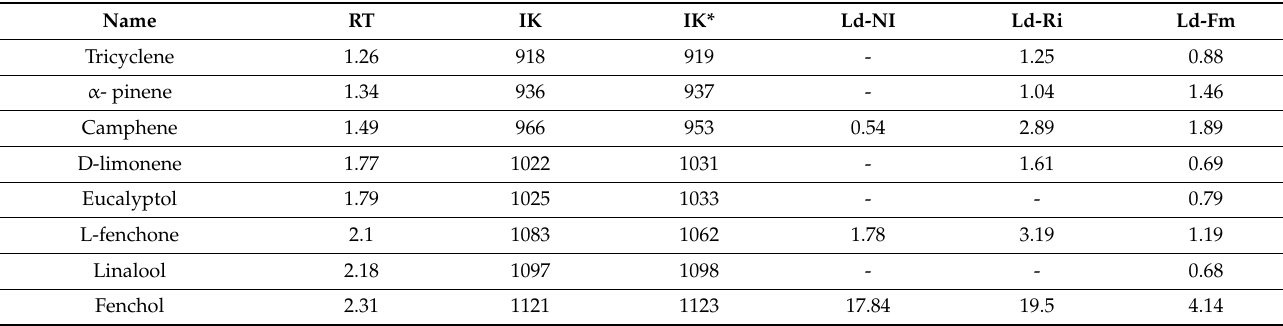
Table 3. Chemical composition of essential oil (in %) in inoculated and non-inoculated L. dentata after 4 months of culture. RT—retention time; IK—Retention indices measured relative to n-alkanes